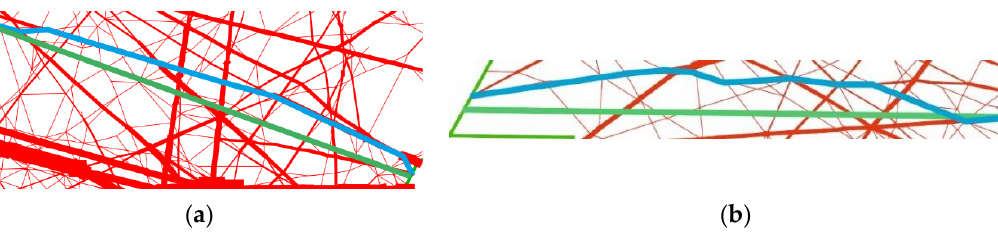
Figure 13. Example with as-flown trajectory (green) and reduced trajectory (blue) for Scenario 1 ( a , SSPD 5.7) and Scenario 2 ( b , SSPD 4.0).